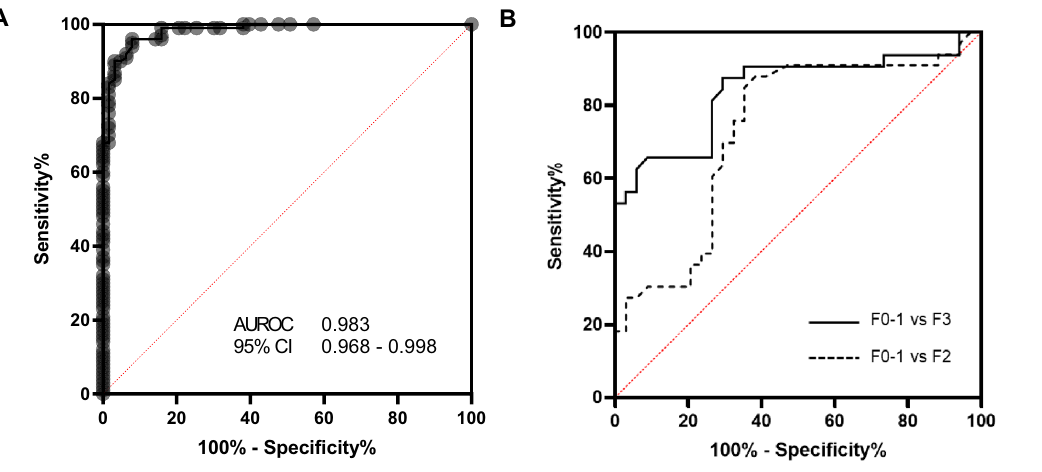
Figure 4. Receiver operating characteristics (ROC) curves analysis comparing ( A ) HCV study cohort (AUROC = 0.983) with controls and ( B ) early liver fibrosis cases with moderate (F2), or severe (F3) and